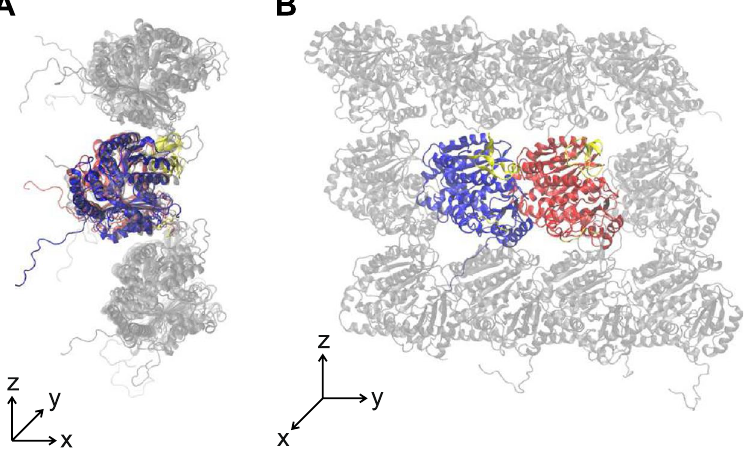
Figure 6. An example of the simulated tubulin system composed of 12 monomers (the S1 system is shown). The surrounding monomers are shown in gray. Tubulin tails are modeled and free to fluctuate and rearrange during the simulation. The system is shown in the plane perpendicular to the microtubule axis ( A ) and parallel with the axis ( B